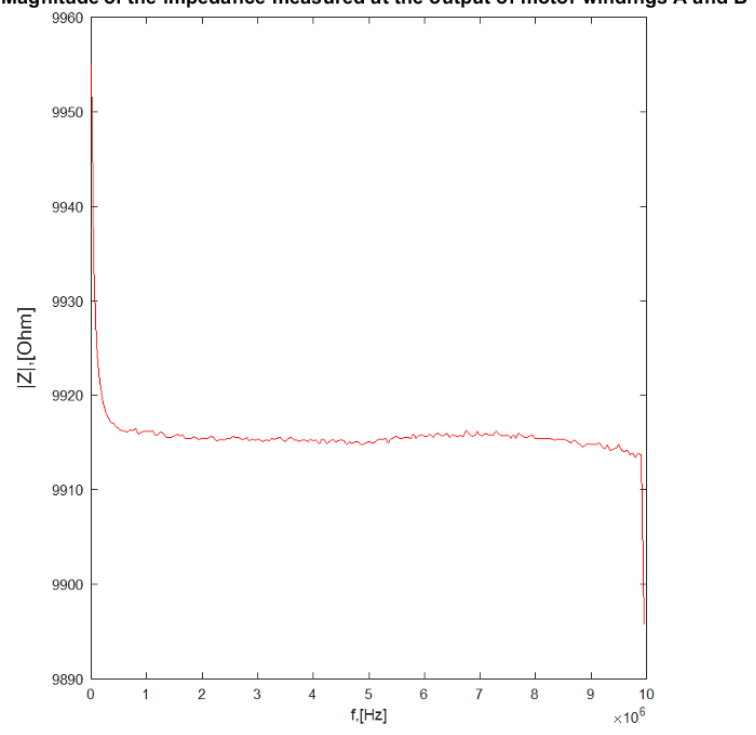
Figure 17. Linear characteristics of the impedance of the output of the “A” and “B” motor windings as a function of frequency.